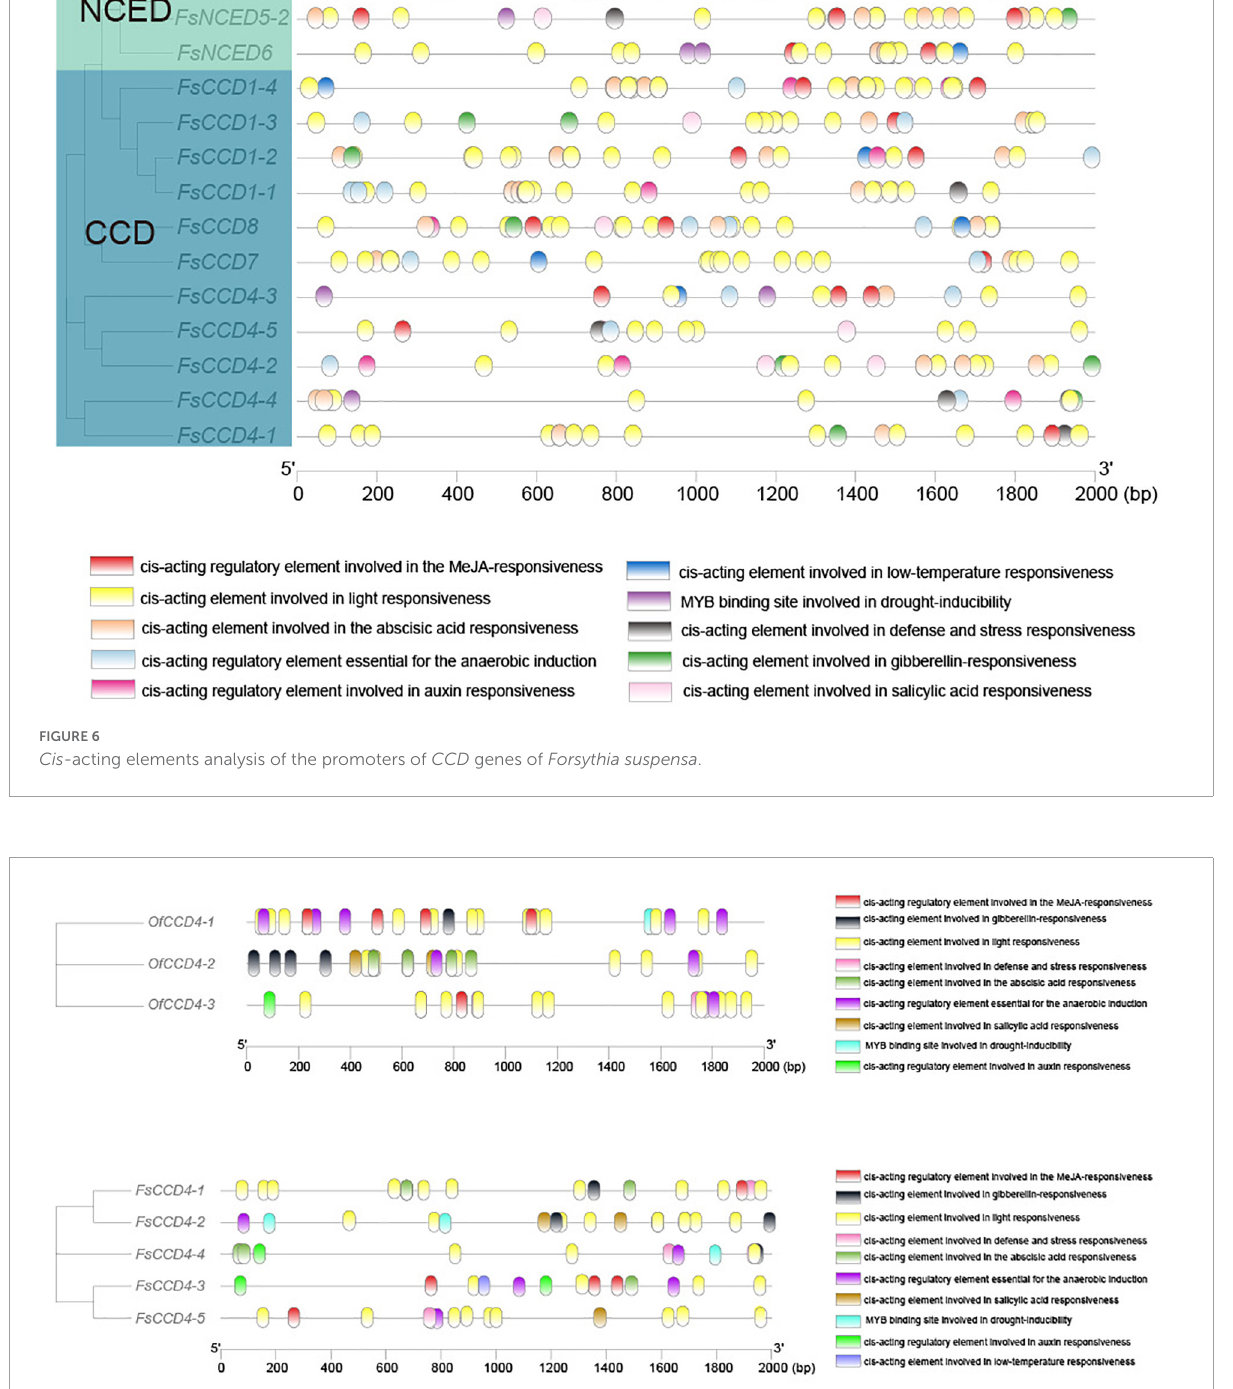
FIGURE7 Cis -acting elements analysis of the promoters of CCD4 genes of Forsythia suspensa and Osmanthus fragrans .